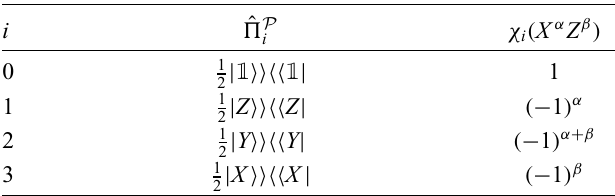
TABLE IV. The irreps, projectors, and characters of the Liou- ville representation of Z 2 .